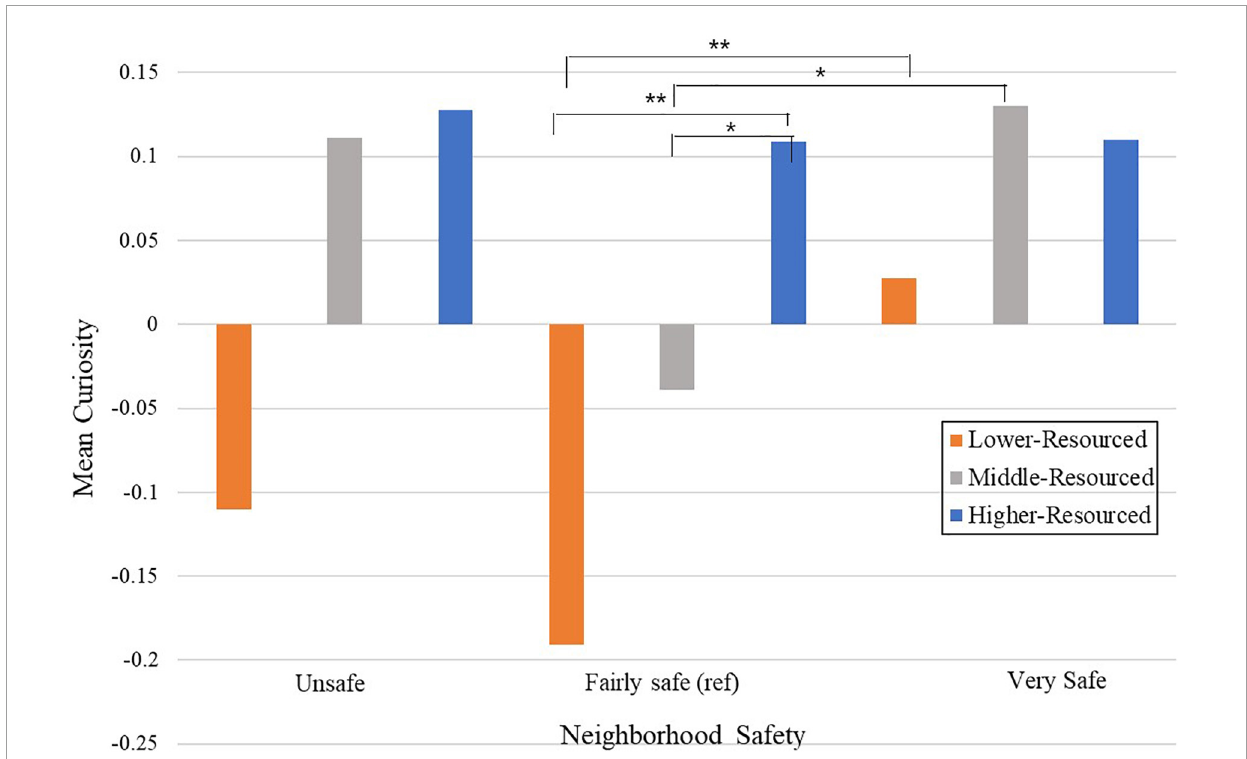
FIGURE1 Mean parent-reported curiosity at kindergarten, and neighborhood safety, stratified by lower-, middle-, and higher-resourced environments (SES-tertiles). * p < 0.05; ** p < 0.01. Source: U.S. Department of Education, National Center for Education Statistics, Early Childhood Longitudinal Study, Birth Cohort. Selected years